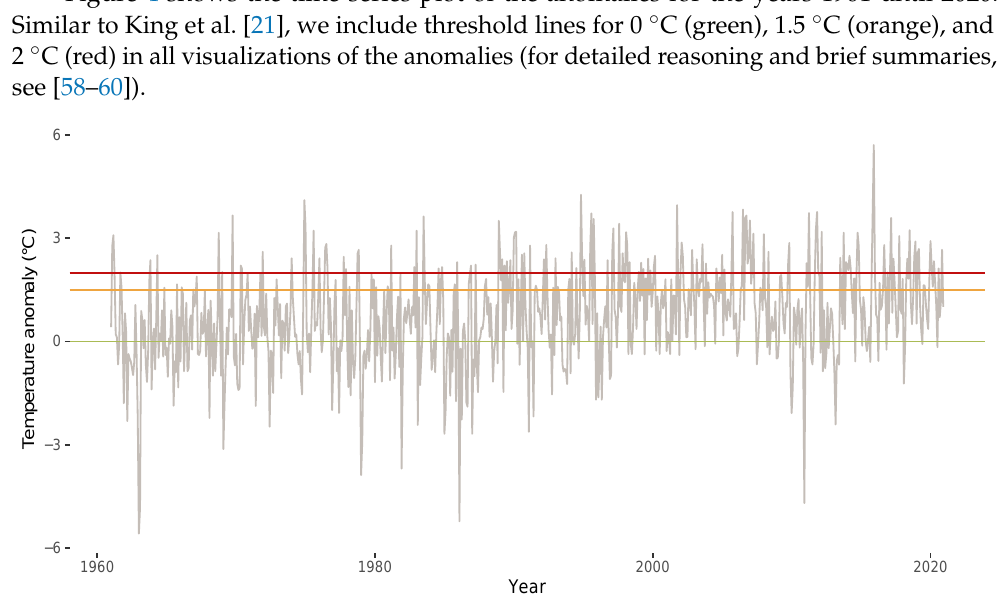
Figure 4. Anomalies for years 1961 until 2020 (grey line). Horizontal lines indicate anomalies of 0 ◦ C (green), 1.5 ◦ C (orange), and 2 ◦ C